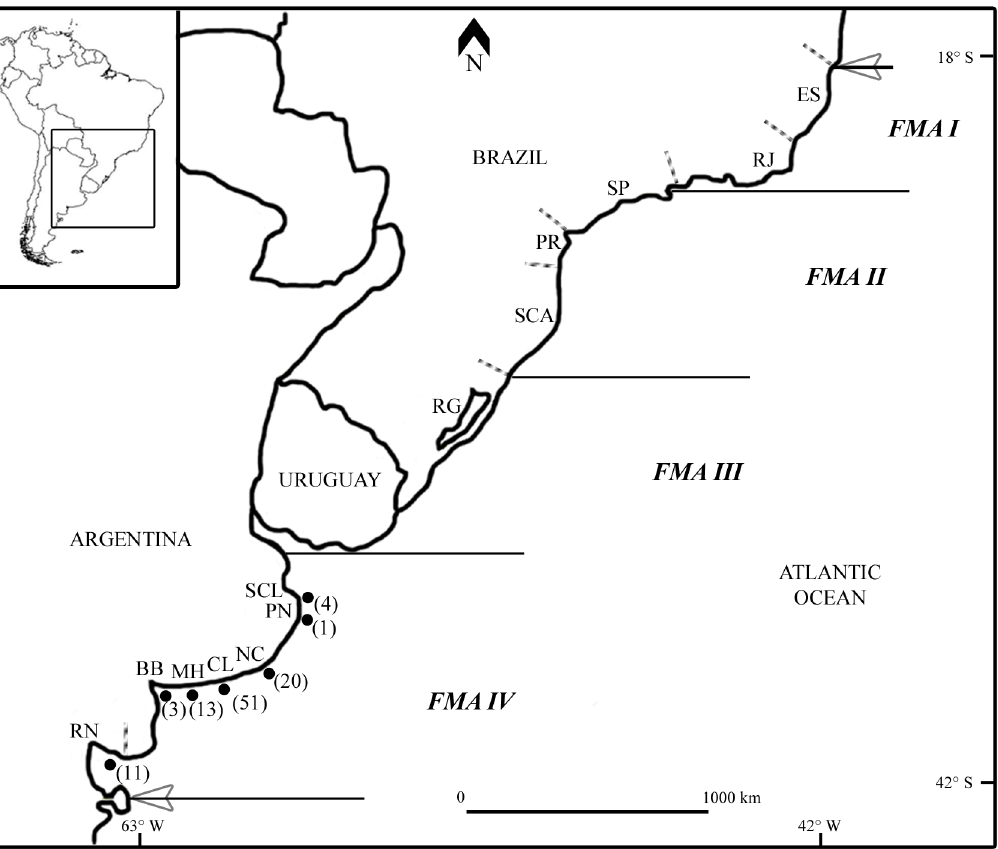
Fig 1. Franciscana Management Areas (FMAs) and sampled sites. Previously proposed FMAs (FMA I-VI) [24] are delineated with solid lines. The number of samples is shown between brackets. ES: Espíritu Santo; RJ: Rio de Janeiro; SP: S ã o Paulo; PR: Paraná; SCA: Santa Catarina; RG: Rio Grande do Sul; SCL: San Clemente del Tuyú; PN: Pinamar; NC: Necochea; CL: Claromecó; MH: Monte Hermoso; BB: Bahía Blanca; RN: Río Negro. Note: Sample size for CL (N = 51) corresponds to 31 samples from Lázaro et al . [5] and 20 samples from this study.